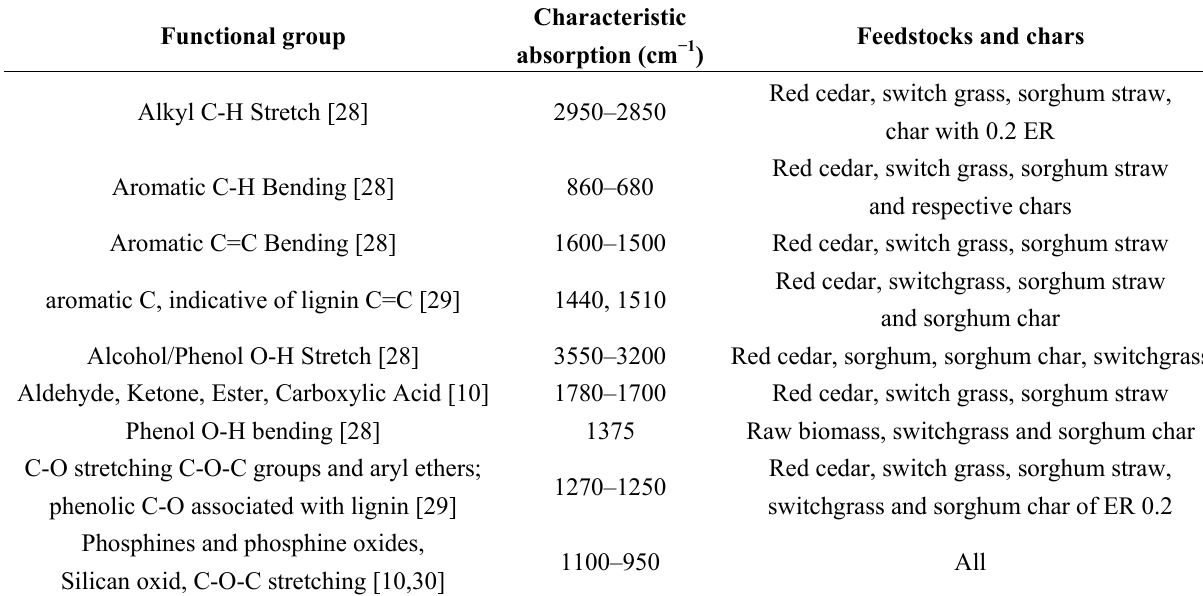
Table 5. ATR FT-IR characteristic absorption of feedstocks and